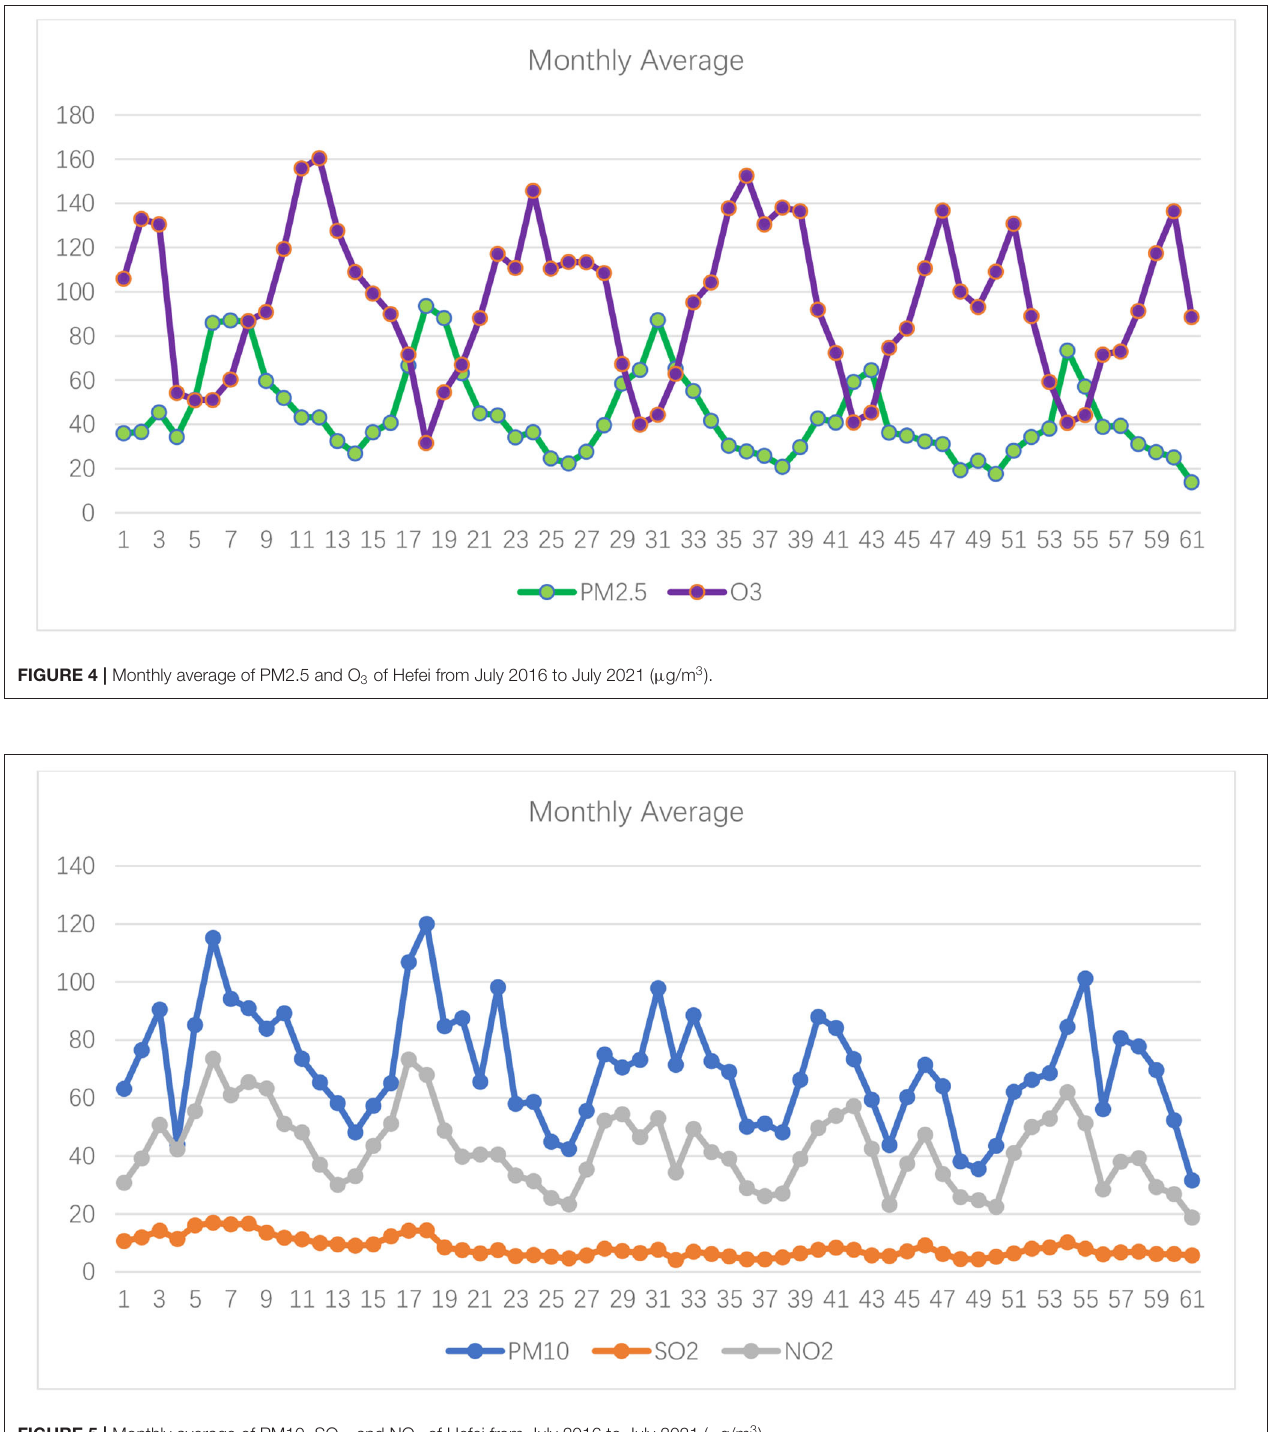
evaluation factor, while S im (1) represents the lower threshold of the m-th grade (the highest level) of the i-th pollution